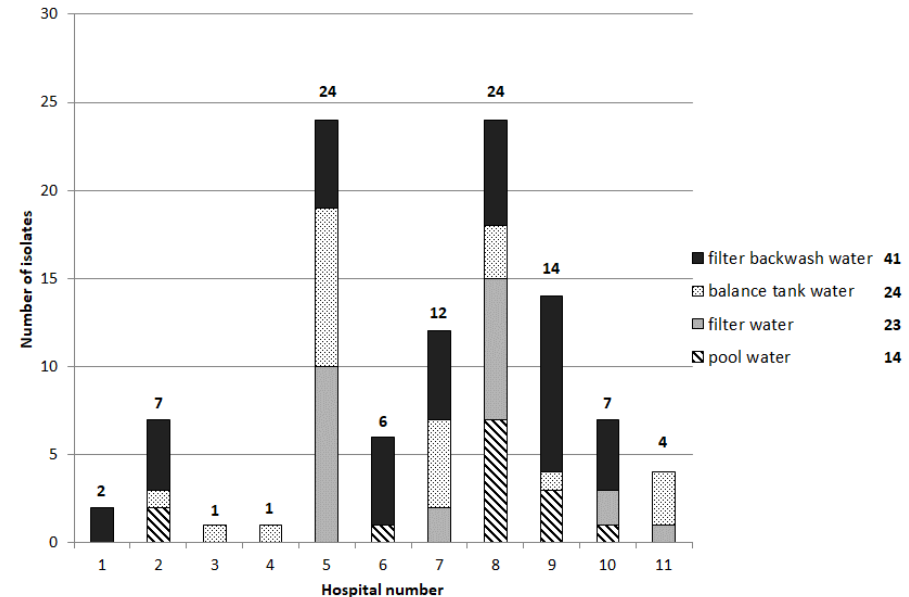
Figure 2. Number of antibiotic-resistant isolates (growth on selective media) from the water samples ( n = 155).